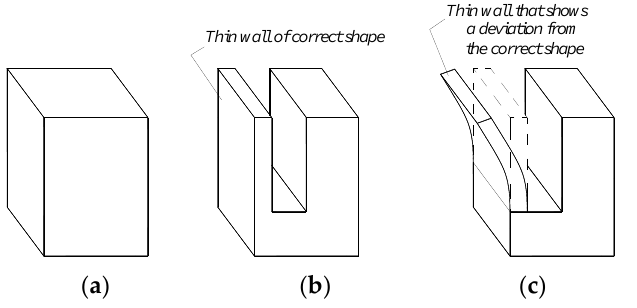
Figure 1. Bending of the thin wall obtained by milling with a disc cutter: ( a ) the initial shape of the semi-finished product; ( b ) the desired shape of the thin pre-net; ( c ) the shape of the thin wall generated by milling with a disc cutter.